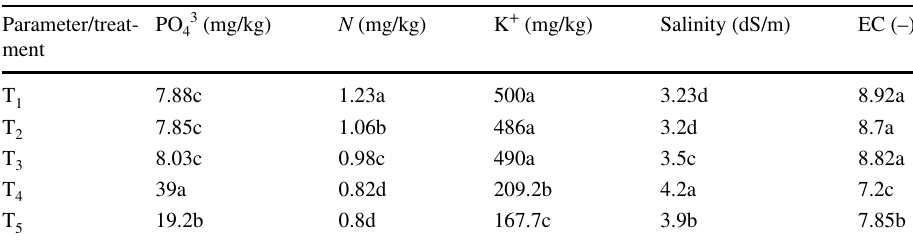
Numbers with common coefficients at 5% probability level were not statistically Table 6 Quality standards for treated wastewater used in irrigation (FAO 1989)